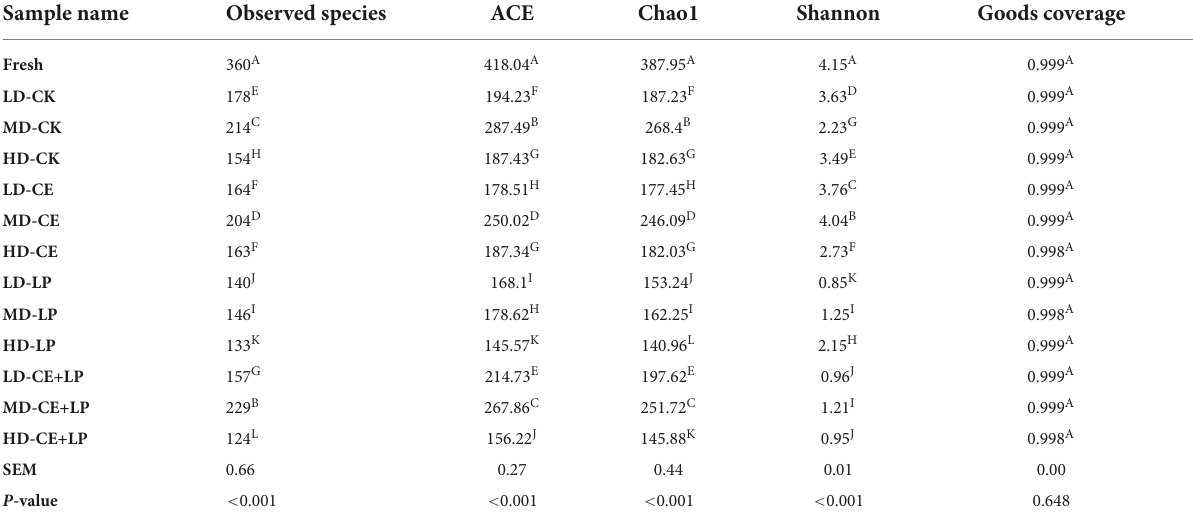
TABLE 6 Diversity and richness of the bacterial microbiota of oat